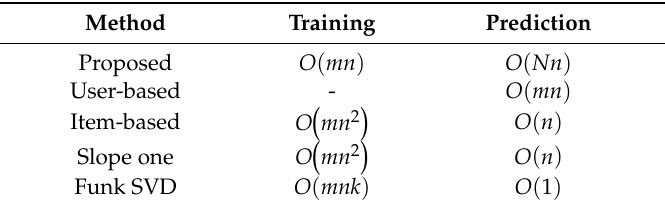
Table 4. Computational complexities.